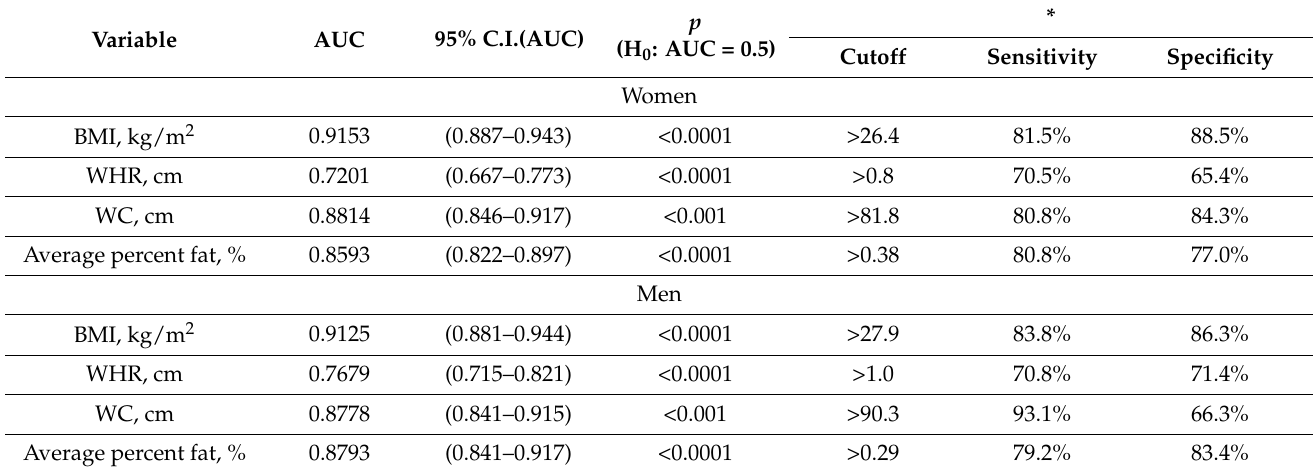
Table 5. The perception of overweight and obesity among women and men in ROC